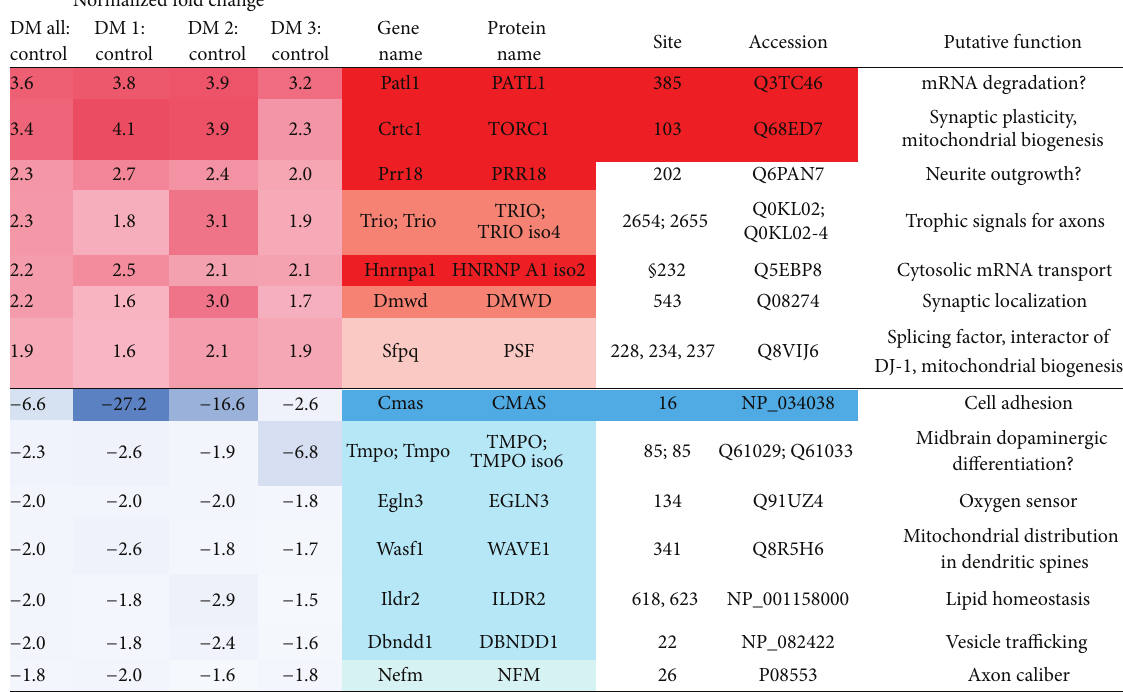
Figure 2: Mouse brain; trypsin digest; mono-methyl-arginine motif antibody #8015/8711. JW Goethe University Hospital (Q153802 8 25) MethylScan